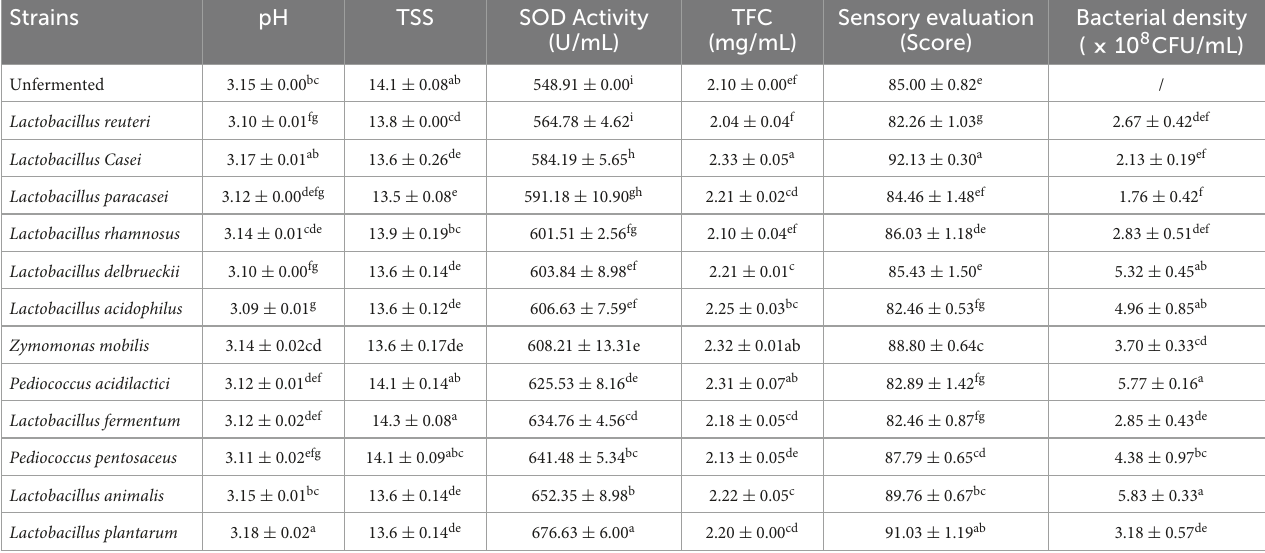
TABLE 5 The characteristics of SBJ fermented by twelve separate strains.